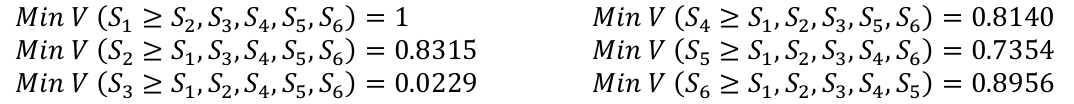
Normalized diaphragmatic relationships matrix